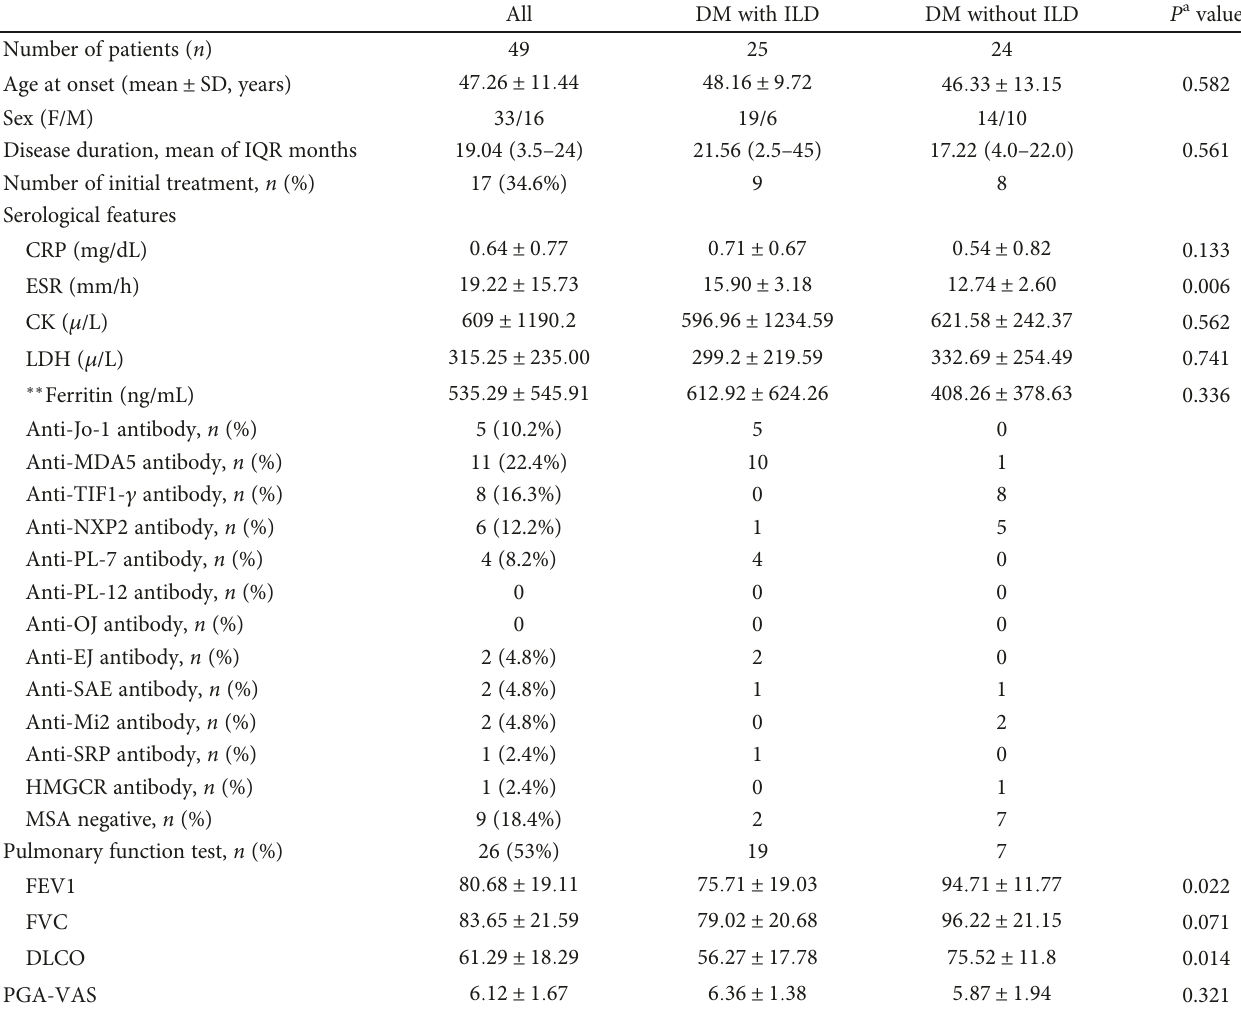
Table 1: Clinical features of the DM